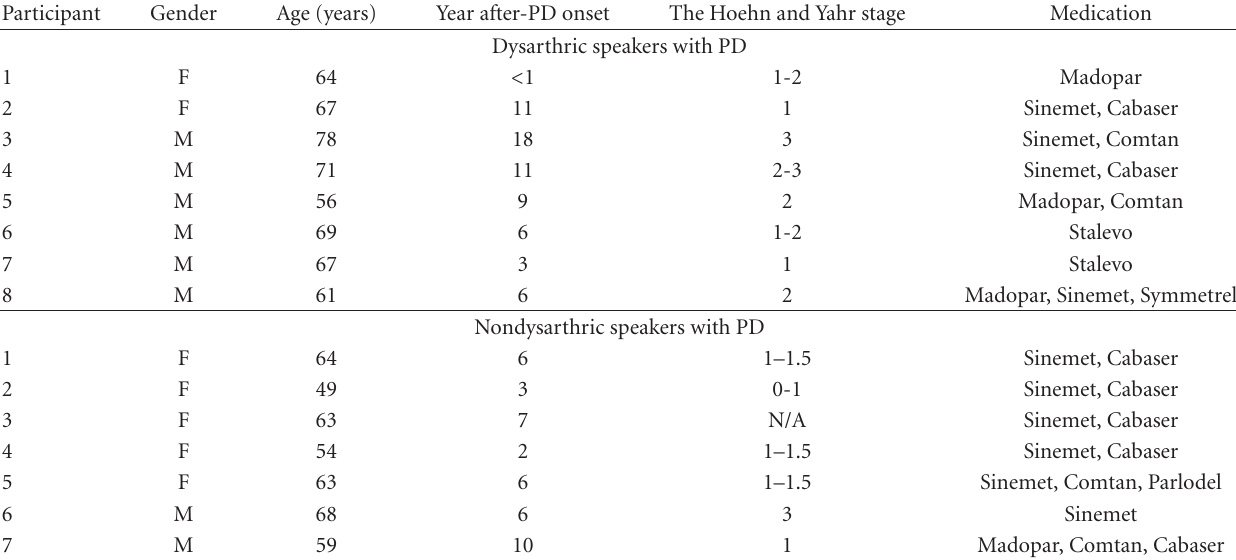
Table 1: Biographical details of the dysarthric and nondysarthric speakers with Parkinson’s disease.